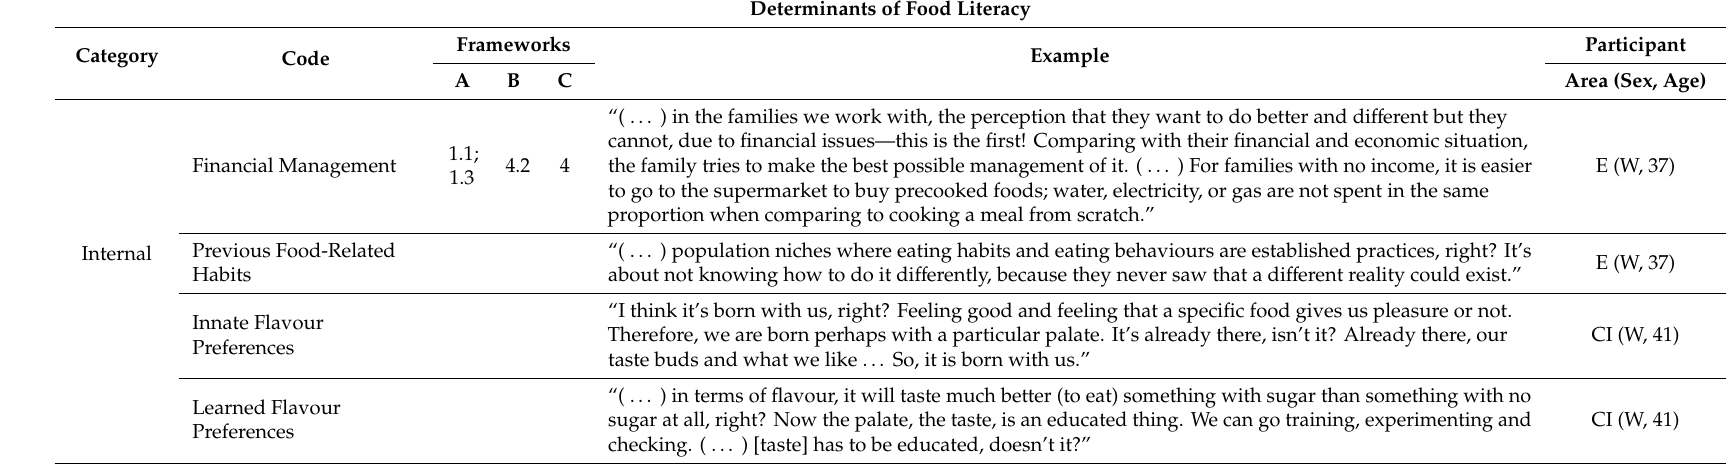
Determinants of Food